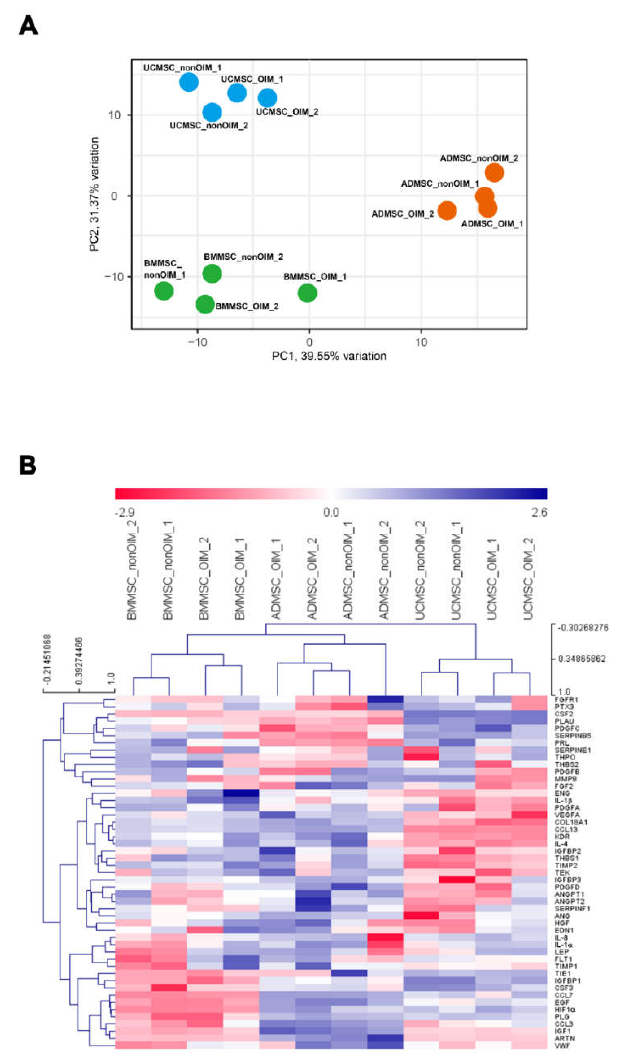
Figure 4. Data visualization of DCt values after qPCR. (A) A principal component analysis (PCA) of DCt values. The PCA plot was from the viewpoint of the samples, and variances of PC1 and PC2 were 39.55% and 31.37%, respectively. (B) A hierarchical clustering (HCL) of genes and samples. Red and blue colors represented higher and lower expression levels of genes, respectively. DCt values were normalized using GAPDH as a reference gene.